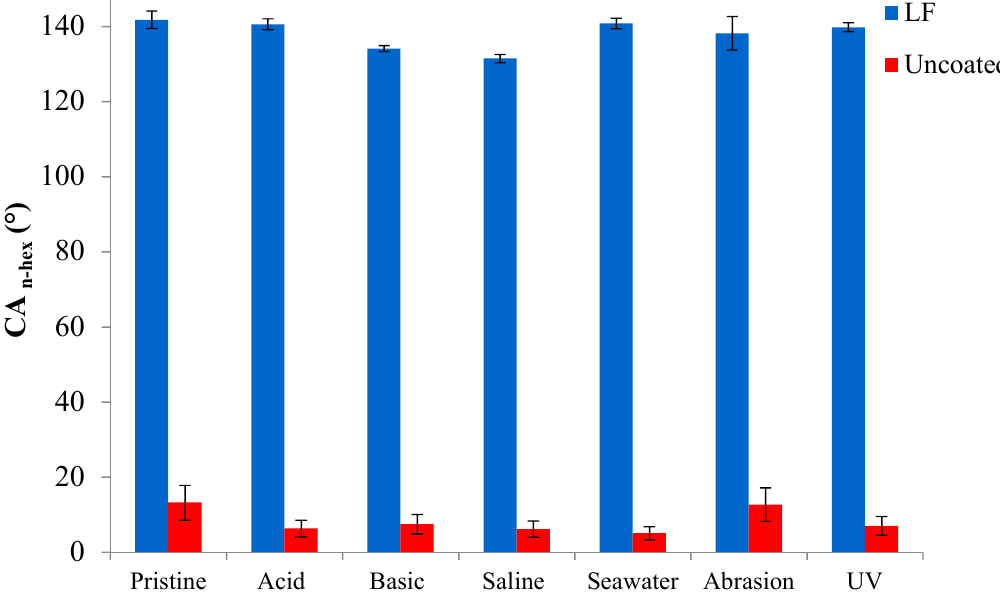
Figure 9. Contact angle against n-hexadecane (CA n-hex ) of uncoated (in red) and LF (in blue) samples before (“pristine”) and after ageing tests.